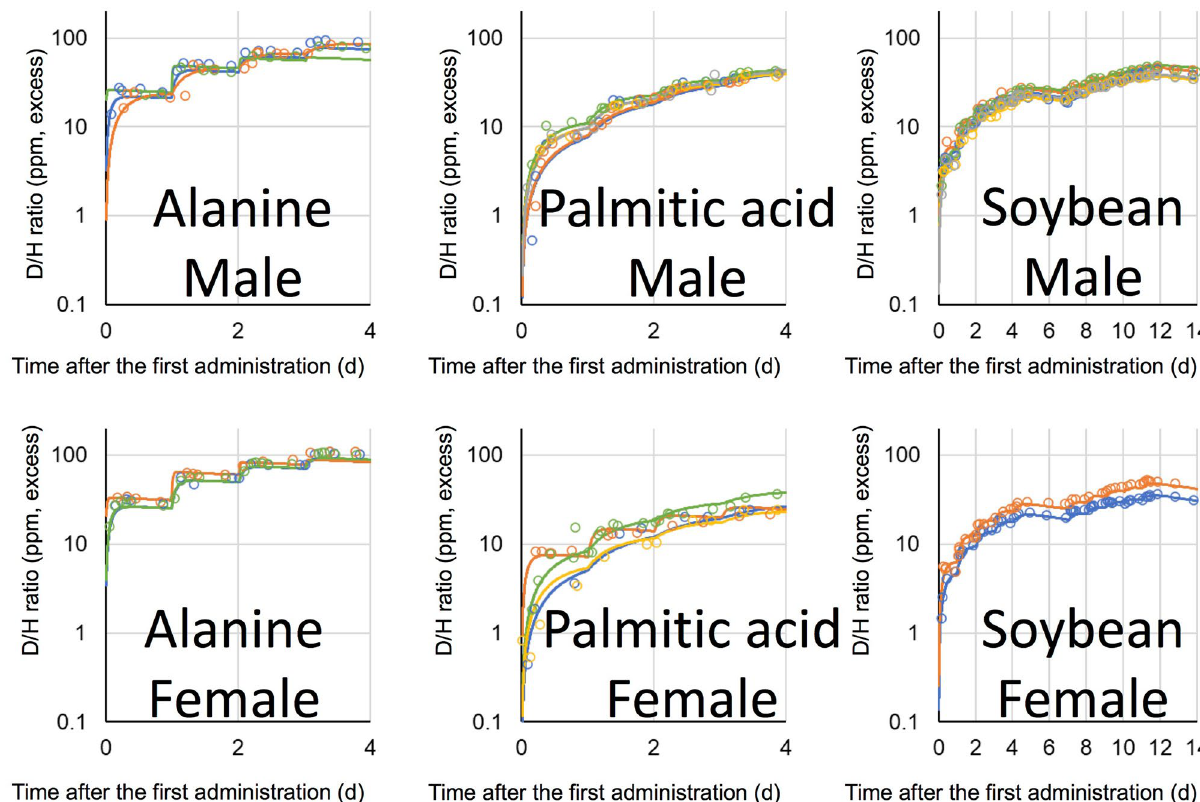
Figure 5. D/H ratios in urine after the oral administration of D-labelled alanine, palmitic acid, and soybean for 4, 4, and 14 days, respectively; all panels are the enlargement of the same data shown in Figs. 3 and 4. The ratio was normalized to the same dosage per body weight (1 g D per 70 kg). Lines were fitted using a model shown in Fig. 1. Each colour represents a different volunteer. D-labelled alanine and palmitic acid were administered over four successive days. D-labelled soybean was administered daily for 2 weeks, except for Saturday and